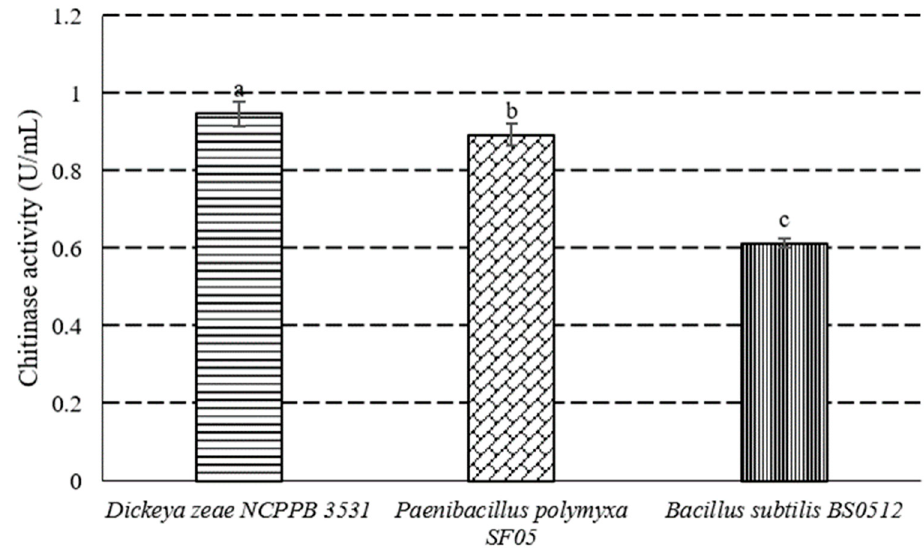
Figure 5. Chitinase activity of D. zeae NCPPB 3531, P. polymyxa strain SF05, B. subtilis BS0512. Different lowercase letters denote significant differences ( p < 0.05).